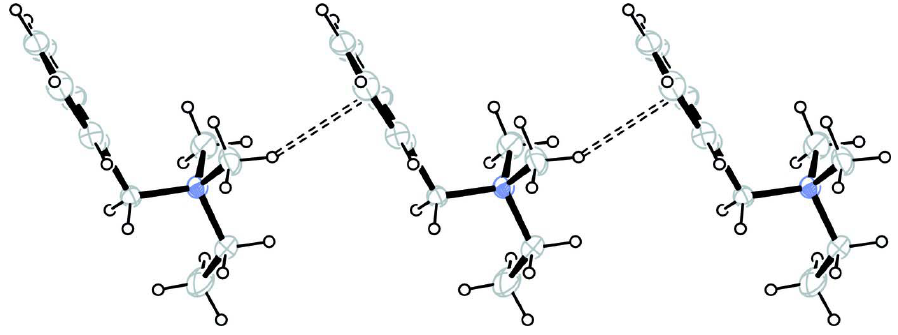
Figure 2 Chain of benzyldimethylethylammonium cations along [100] projected onto (010). The chain is formed due to C—H··· π interactions ( ORTEP - 3 ; Farrugia,